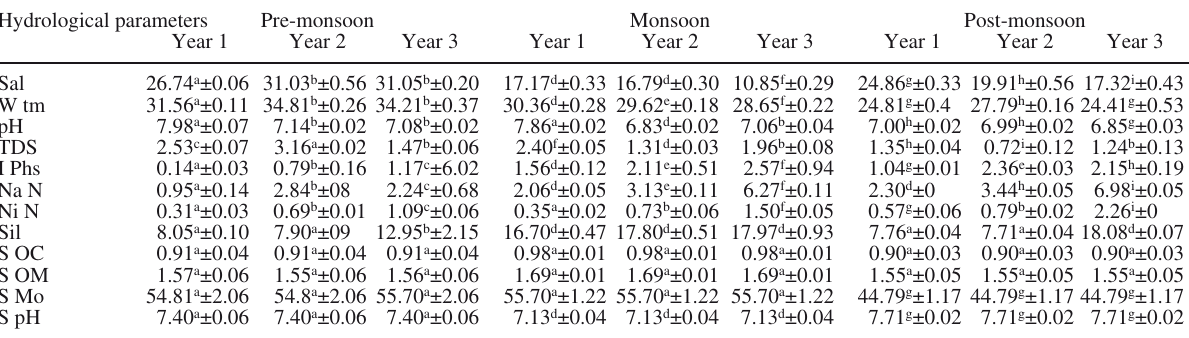
t able 1. – Water and soil parameters (abbreviations are in parenthesis) of studied mudflats of the Indian Sundarbans. Sal, salinity (PSU); W tm, water temperature (°C); TDS, total dissolved solids (gL –1 ); I Phs, inorganic phosphate (µML –1 ); Na N, nitrate-N (µML –1 ); Ni N, nitrite-N (µML –1 ); Sil, reactive silicate (µML –1 ); S OC, soil organic carbon (%); S OM, soil organic matter (%); S Mo, soil moisture (%); S pH, soil pH.